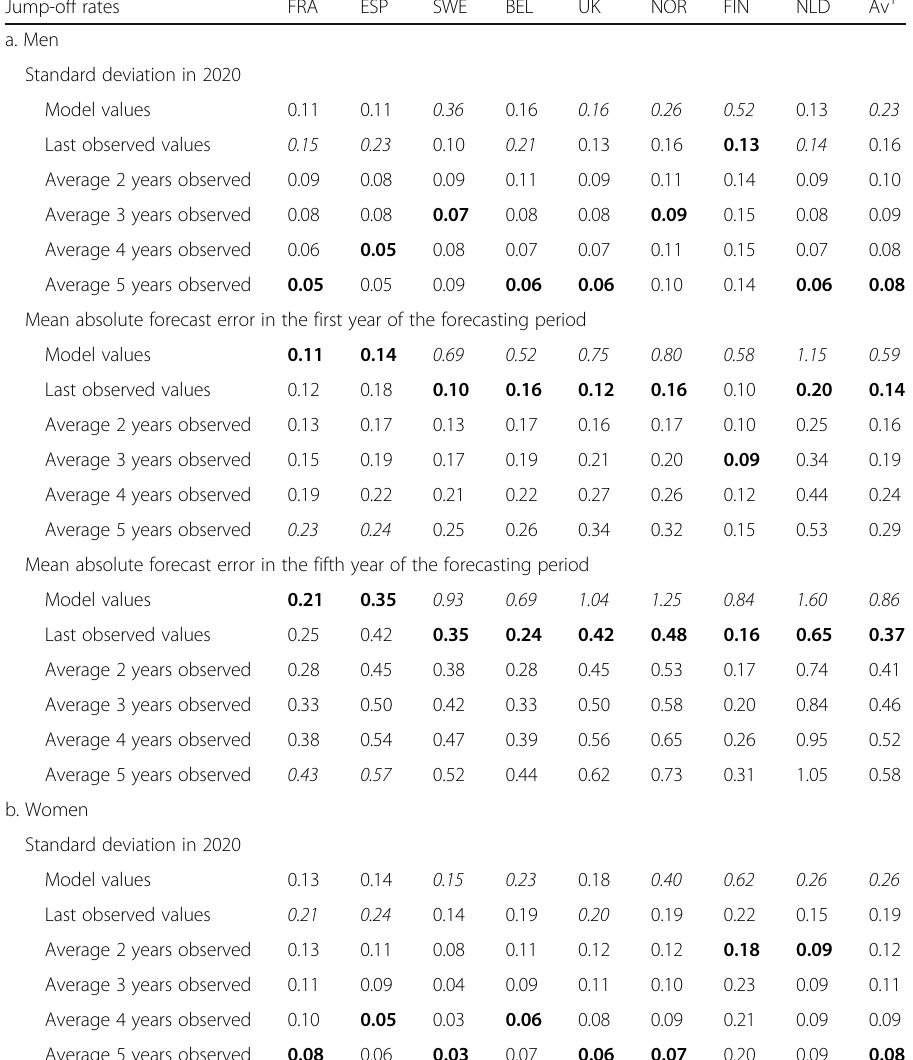
Table 8 Mean absolute forecast error (MAFE) of remaining life expectancy at age 65 for the first and fifth year in the forecasting period, and standard deviation (SD) of the increase/decrease of the life expectancy at age 65 in 2020 between ten successive forecasts, for six different choices of the jump-off rates applied to a Lee-Carter model, for eight countries, men (a) and women (b), fitting periods 1960 – 2005, 1960 – 2006, … , 1960 – 2014 Jump-off